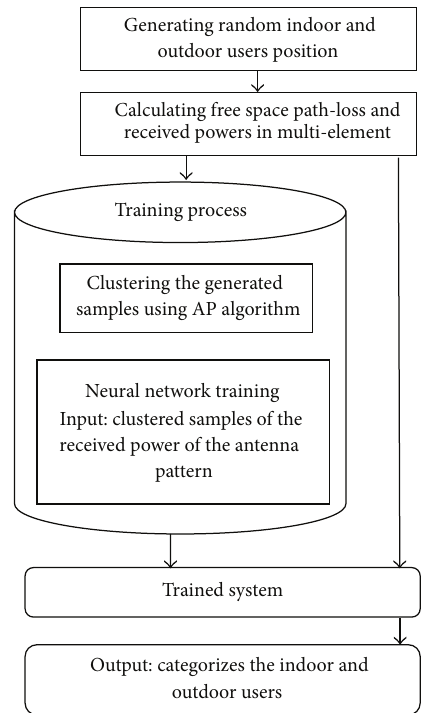
Figure 2: Proposed femtocell user selection technique using ANN and AP